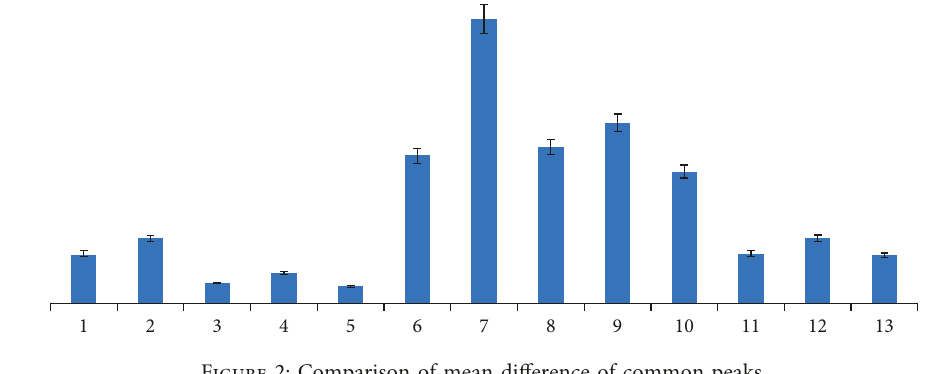
Figure 2: Comparison of mean difference of common